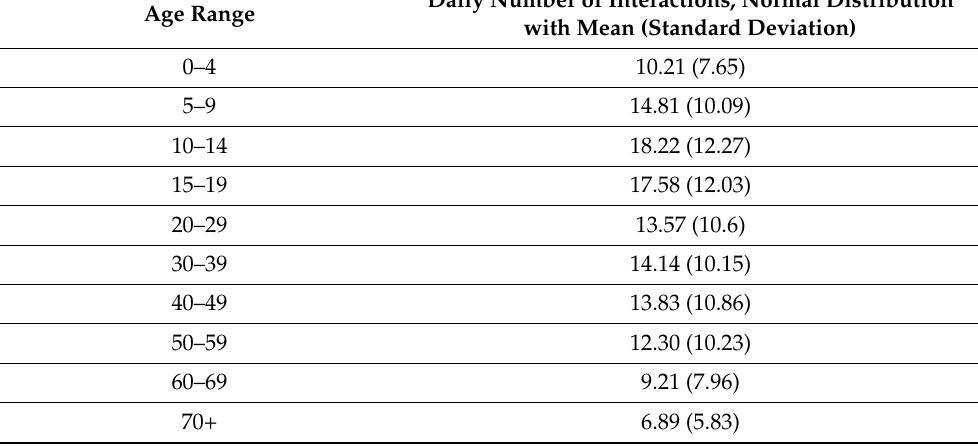
Table A5. The daily number of interactions of people based on age [44]. Age